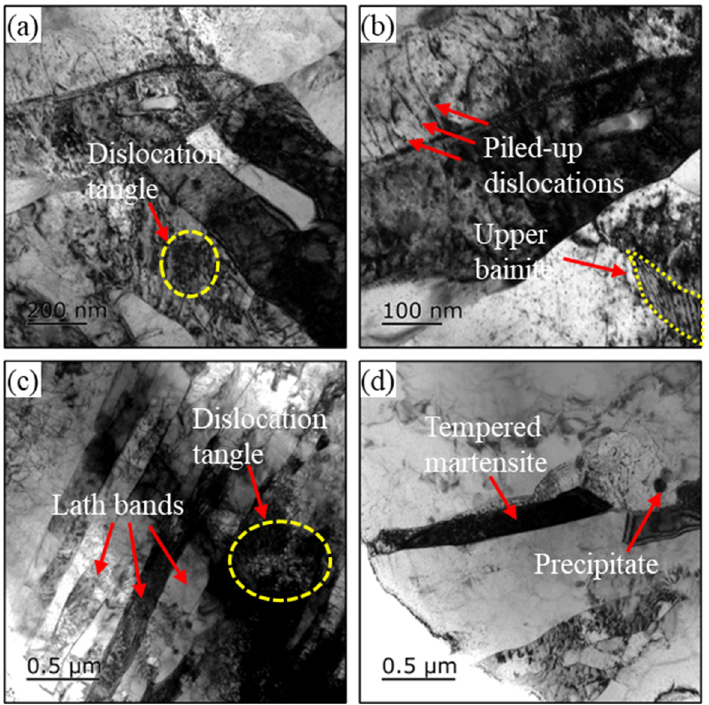
Figure 11. TEM images of different typical microstructural characterisations in specimen No. 2: ( a ) dislocation tangle, ( b ) piled-up dislocations and upper bainite, ( c ) lath bands and ( d ) tempered martensite and precipitate.